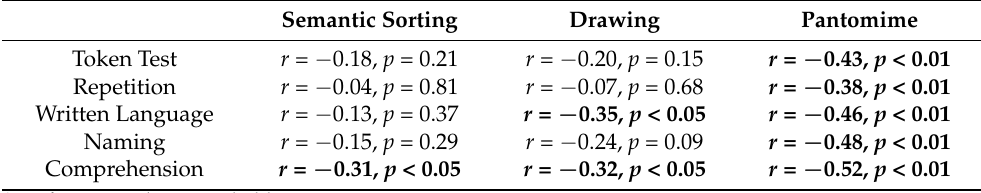
Table 2. Results for the calculation of the correlation (Pearson) of the subtests of the NVST with standard neurolinguistic measures (AAT) for 51 persons with aphasia (PWA). Negative correlations reflect that high scores indicate severe impairment in the NVST, but mild impairment in the AAT.